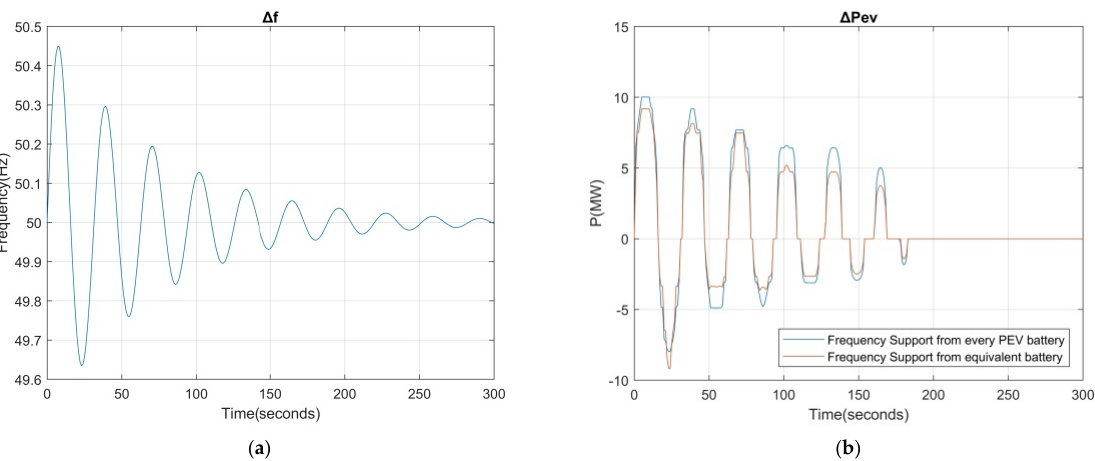
Figure 10. ( a ) A random frequency deviation from nominal value (50 Hz); ( b ) power generation when fuzzy frequency controller is implemented either separately or in total.